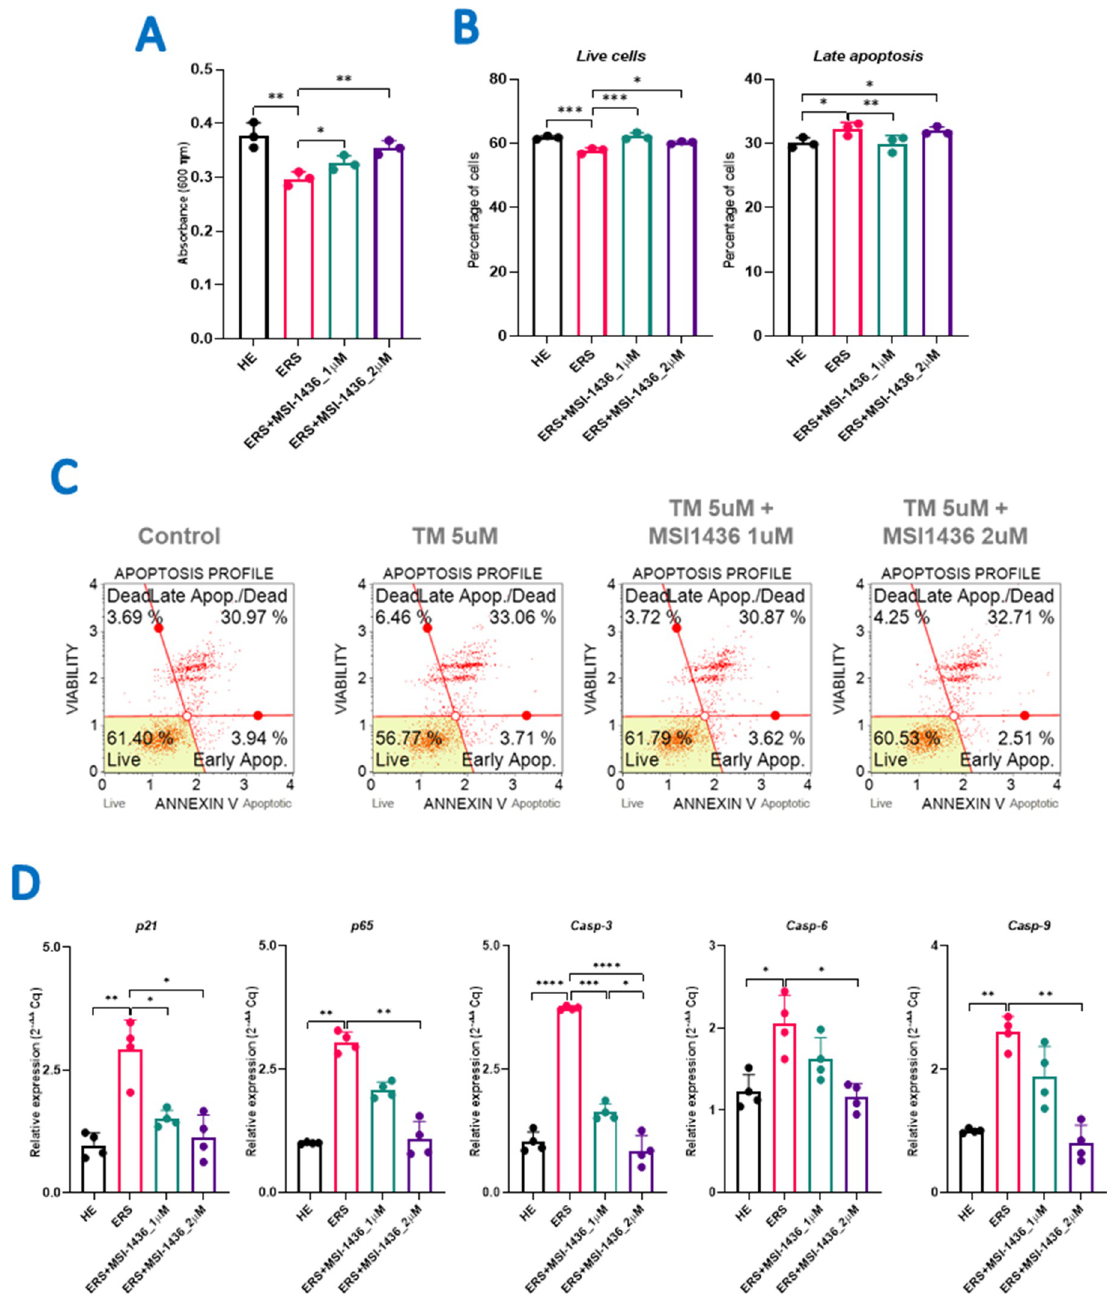
Fig 1. Evaluation of cell viability and apoptosis in MIS-1436 preconditioned or non-treated HepG2 cells following TM-induced ER stress. ( A ) Proliferative rate of treated and untreated HepG2 cells assessed using the Tox8 assay. (B) Bar charts depicting the percentage of total live and apoptotic cells. (C) Annexin V & Dead Cells representative plots among three replicates of each determination. (D) Relative gene expression of key apoptosis associated regulators and effectors. The results are expressed as the mean of 3 different experiments ± SD. Asterisks refer to a significant difference between two groups, where: p < 0.05 ( � ); p < 0.01( �� ); p < 0.001( ��� ); p < 0.0001 ( ���� ). HE: Healthy untreated HepG2 cells; ERS: Endoplasmic reticulum-stressed cells; ERS+MSI: Groups pretreated with MSI-1436 compound before inducing